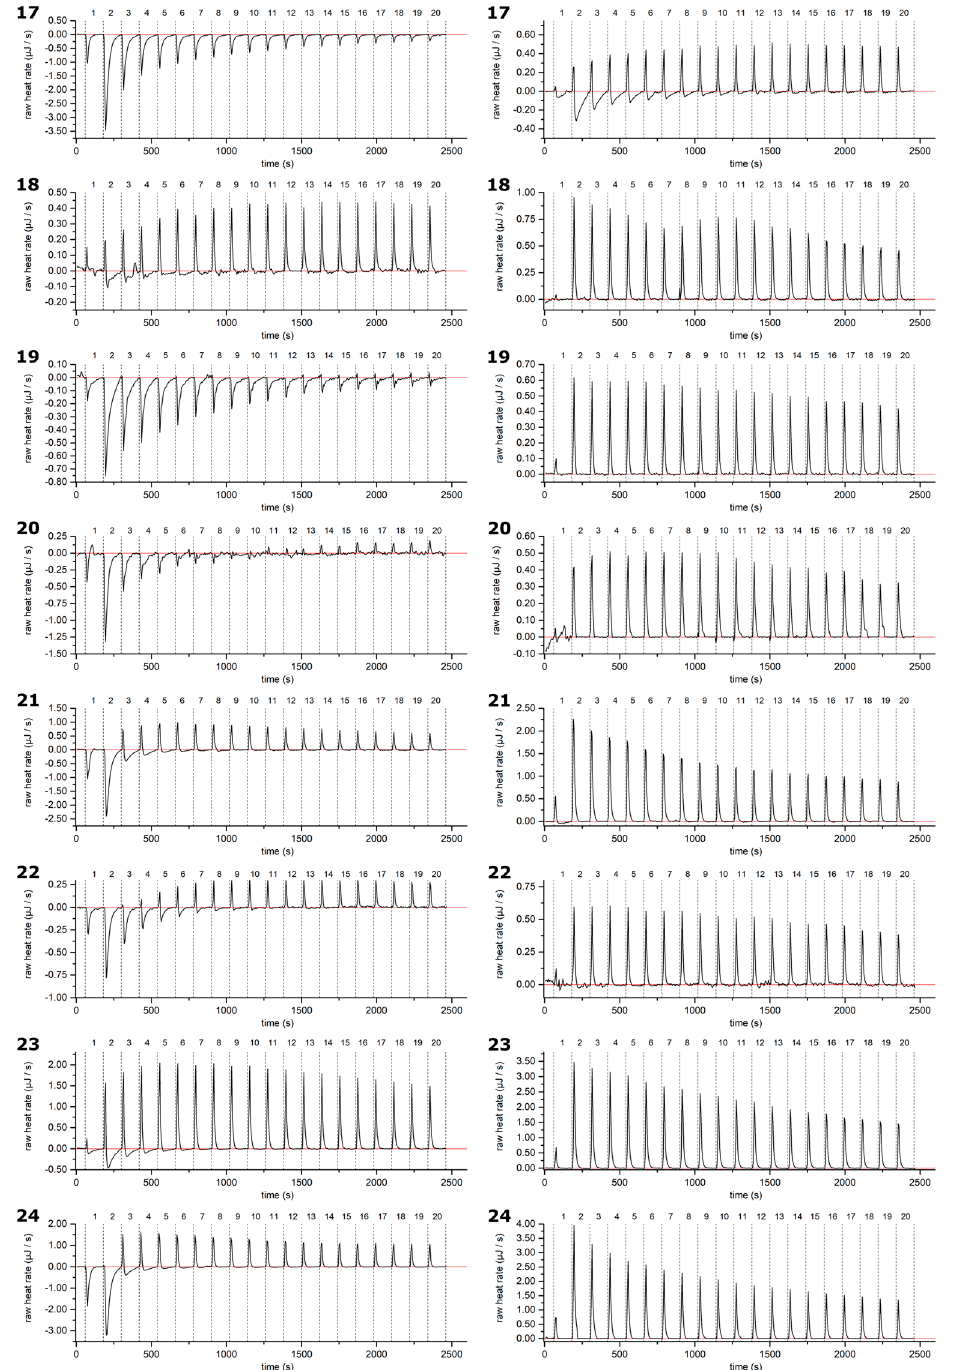
Figure A3. Example thermograms of HTs 17 – 24 samples ( left ) and control ( right , HT titrated into buffer solution): measurements plotted against measurement time. Corrected baseline presented as a red line, and injections separated with dashed lines. HTs are presented in order of ascending molecular weight. For the structures and numbering of HTs, refer to Figures 1 and 2.